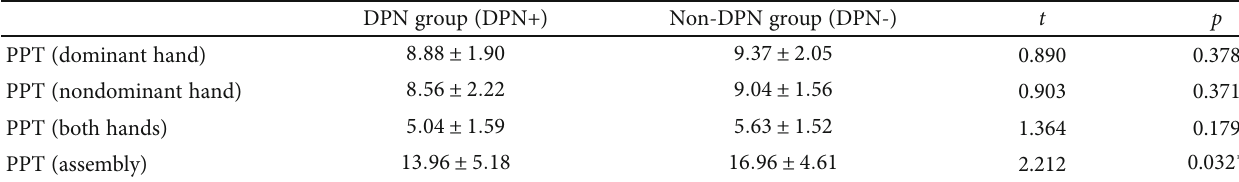
Table 4: Comparison of the scores on the Purdue Pegboard Test (PPT) between the two groups.